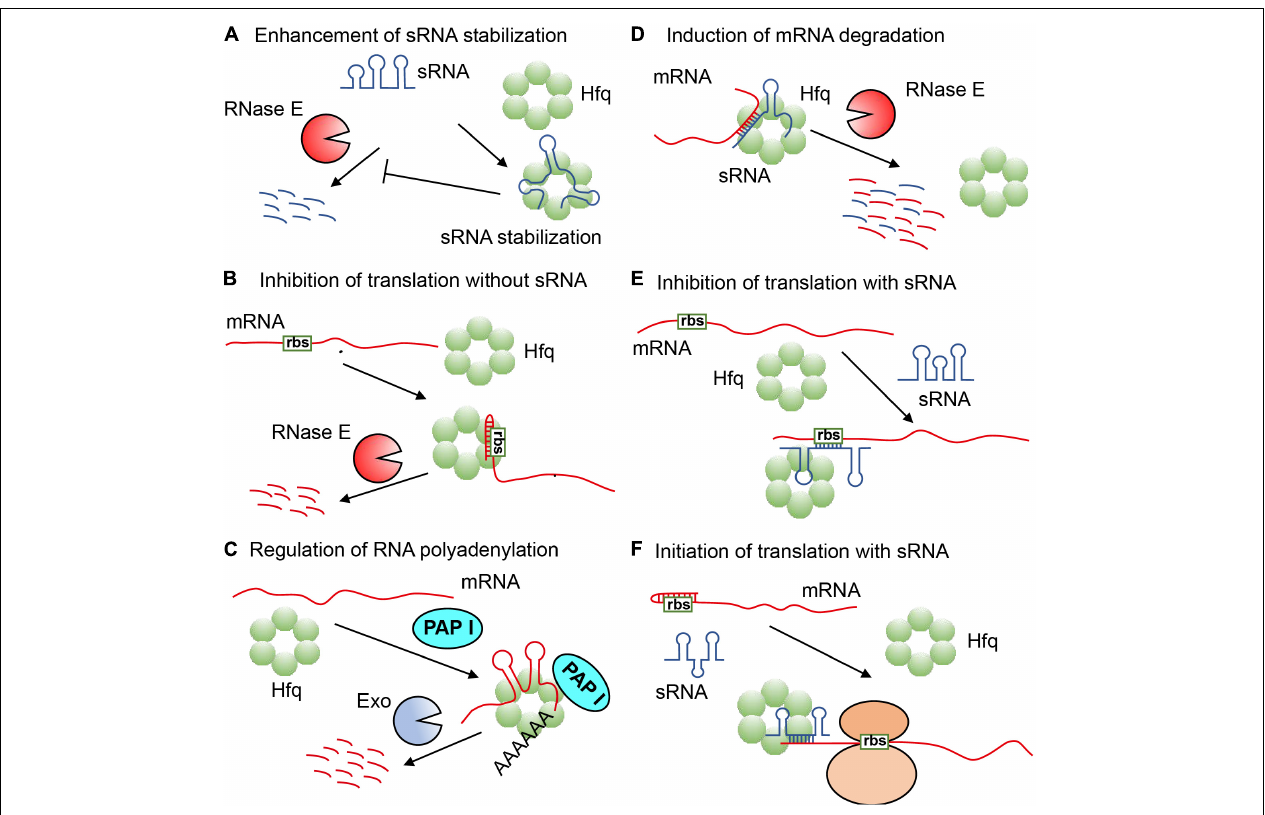
FIGURE 1 | The various regulation mechanisms exhibited by Hfq (Vogel and Luisi, 2011; Dos Santos et al., 2019). (A) Hfq refolds sRNA to protect it from ribonuclease cleavage. (B) Hfq refolds the leader sequence of mRNA to form a stem-loop structure within the ribosome binding site (rbs) to block the formation of translation initiation complex, and cause mRNA to be rapidly degraded by RNase E. (C) Hfq refolds mRNA for polyadenylation by polyA polymerase to promote the degradation of mRNA by an exoribonuclease (Exo). (D) Hfq refolds sRNA and mRNA for partial pairing, causing them to be simultaneously degraded by RNase E. (E) Hfq refolds sRNA and mRNA for partial pairing within the leader sequence of ribosome binding site to inhibit translation. (F) Hfq refolds sRNA and mRNA to expose mRNA ribosome binding site for translation